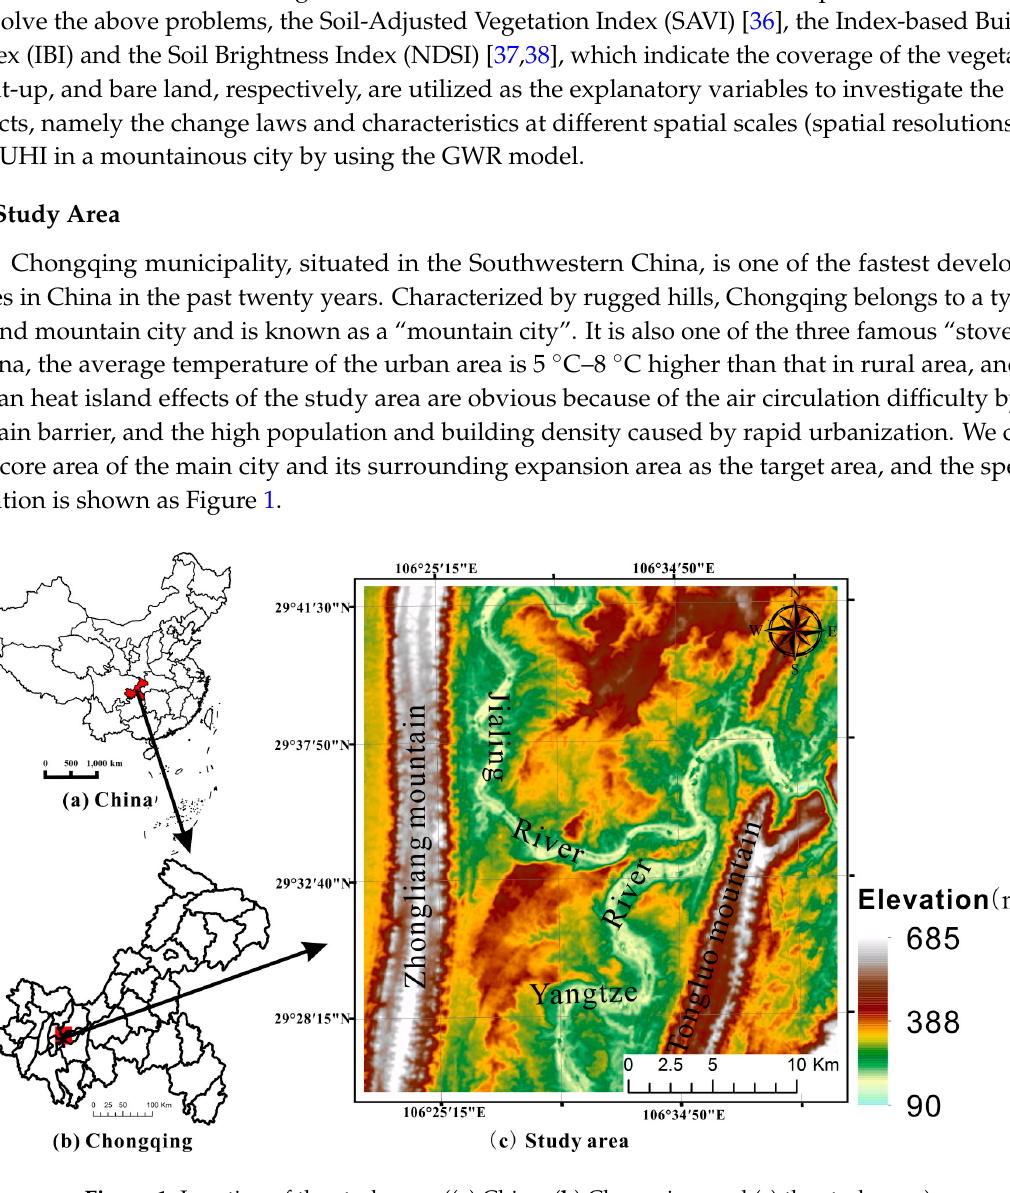
Figure 1. Location of the study area (( a ) China, ( b ) Chongqing, and ( c ) the study area). The study area ranges from 29°25 ′ -29°42 ′ N, 106°22 ′ –106°39 ′ E, and its area is about 845.88 km 2 .